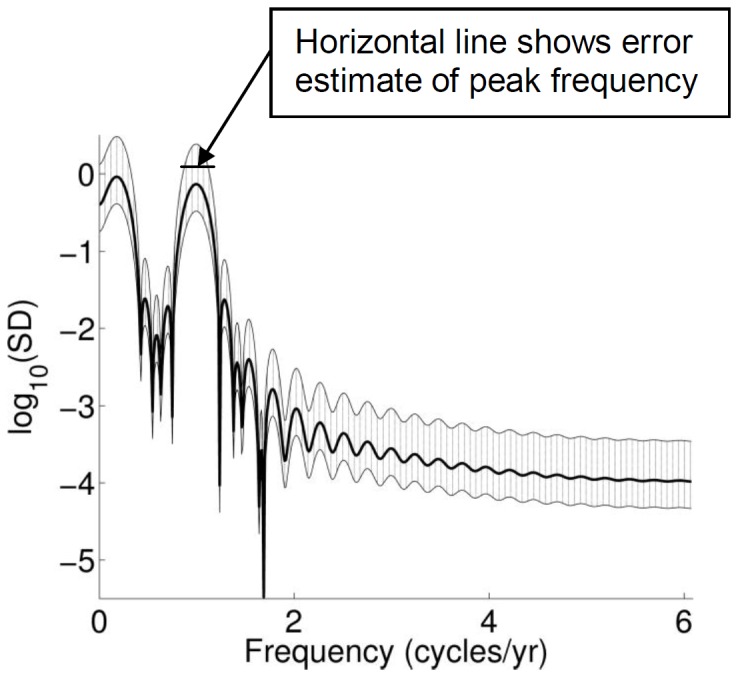
Spectral density plot for the reconstructed component of the SPOs at x = 160 m for transect 58.The thin lines indicate the 95% confidence interval for the spectral estimates. The horizontal line shows the error of the peak frequency estimate for the quasi-yearly cycle.